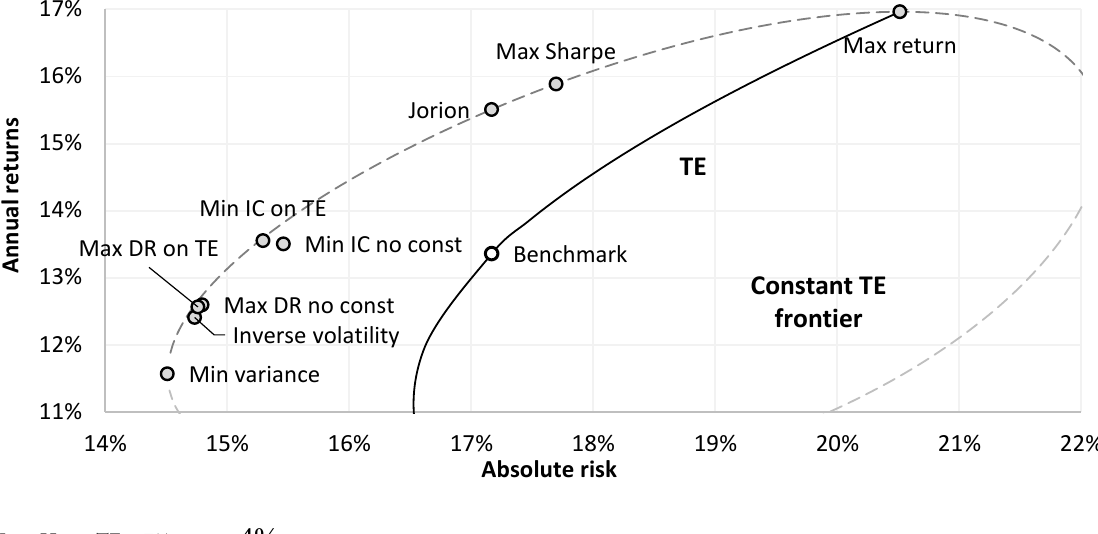
Figure 2. TE frontier, constant TE frontier and portfolio